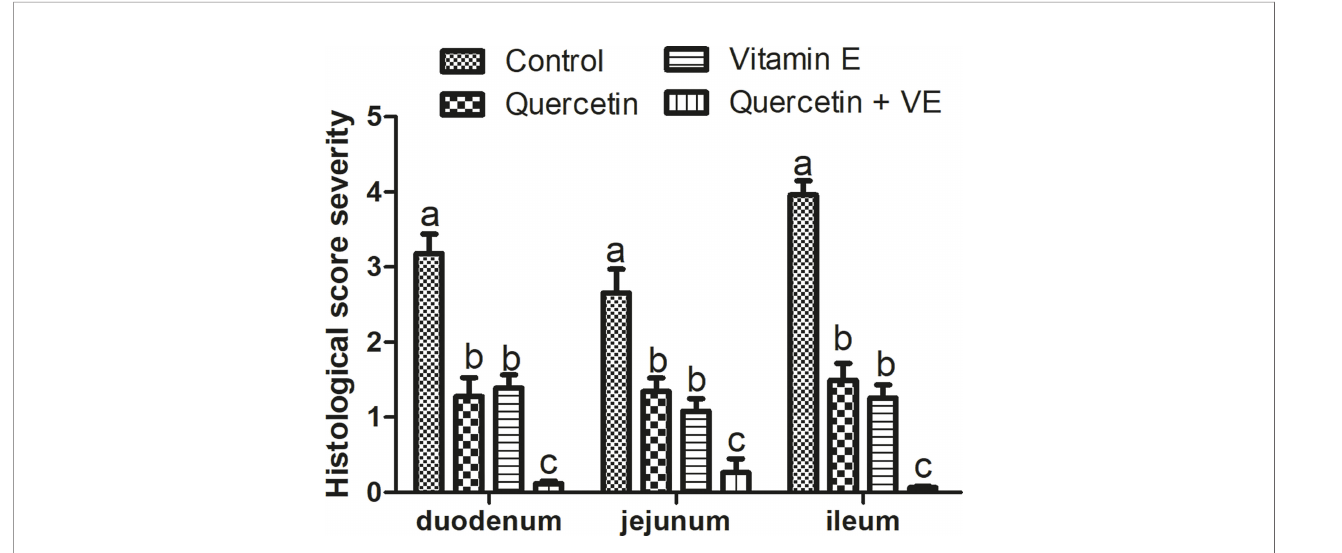
FIGURE 7 | Histopathological severity scores of the four (4) groups. Bars without the same letter differed signi fi cantly (P < 0.05). Scale bar = 20um.